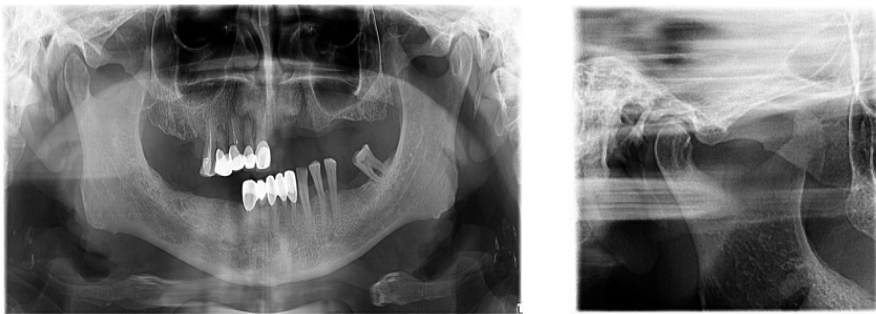
Figure 5. TMJ tomography aspects in patients with periodontal injuries, open and shut position. ( a ) OPT with periodontal injuries; ( b ) TMJ aspect.